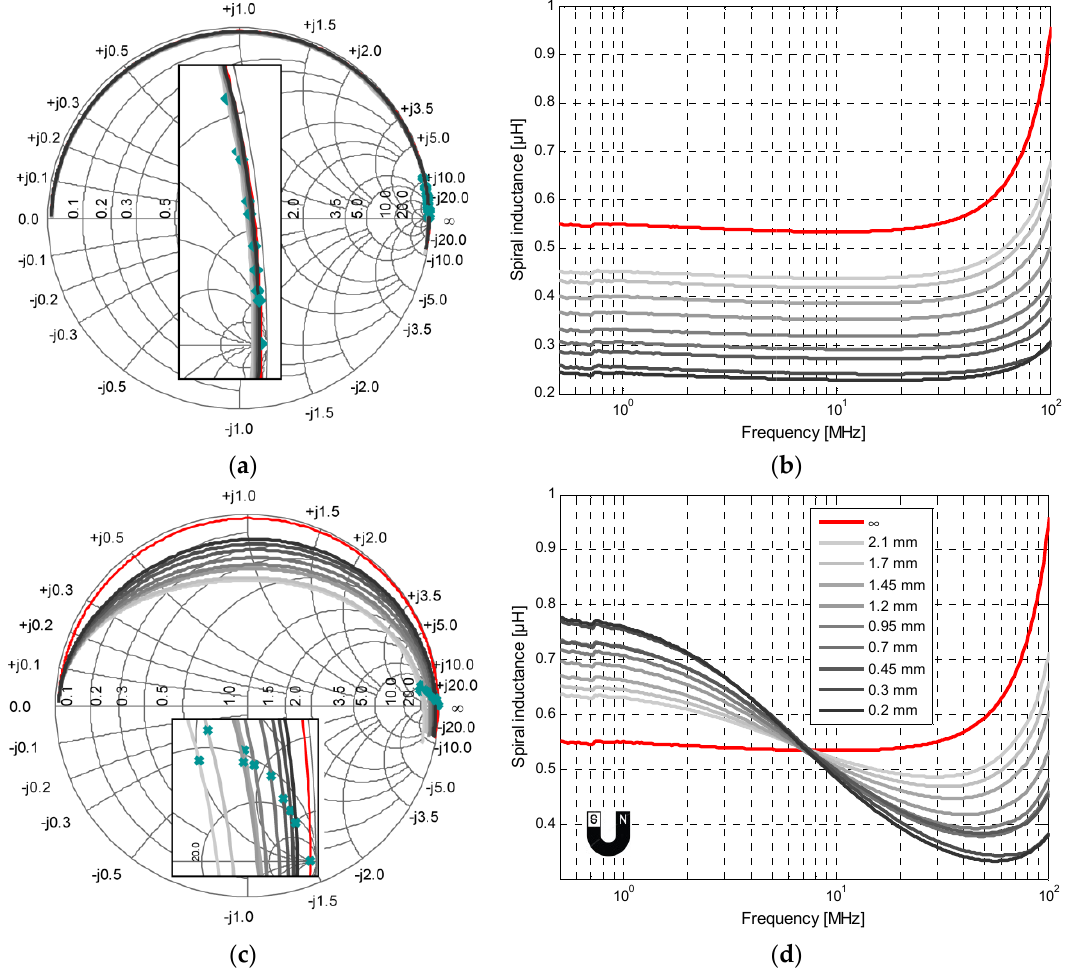
Figure 6. Spiral inductor measurement: with Cu-plate ( a ) S 11 parameter drawn in Smith chart, and ( b ) inductance variation versus frequency, with Fe-plate (Nanocrystalline); ( c ) S 11 parameter drawn in Smith chart; and ( d ) inductance variation versus frequency (the legend on ( d ) applies for all subgraphs). Table 3. Deflection frequencies of different inductance topologies when approximated by ferromag- netic